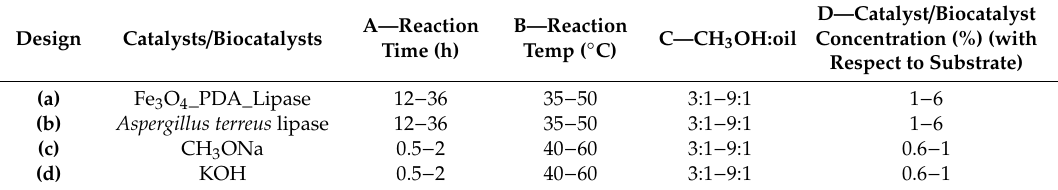
Table 6. The ranges of reaction parameters: reaction time, temperature, CH 3 OH-to-oil ratio and enzyme concentration used for optimization studies of enzymatic and chemical